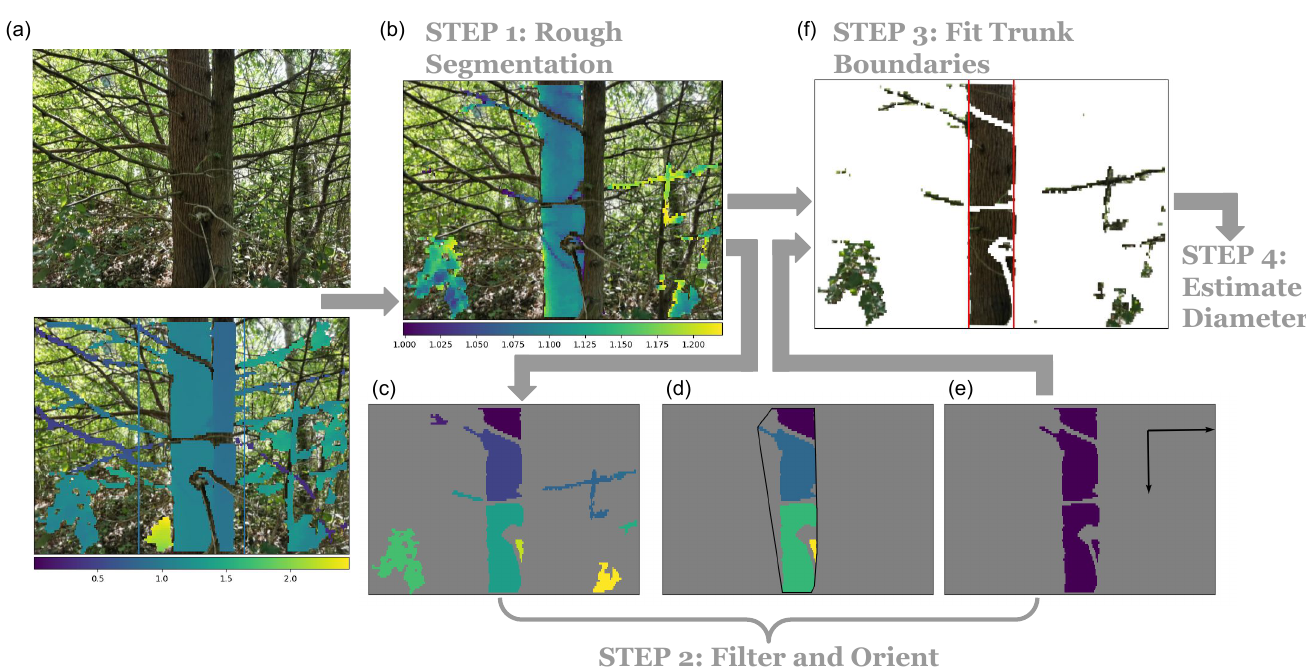
Figure 2. A four-step algorithm filters, orients, and segments captured images before estimating trunk diameter. The steps are demonstrated in the sample image ( a ), with the RGB image on the left and the raw depths overlaid on the right. The roughly segmented depth image ( I s ) is shown in ( b ), and the sub-steps of filtering and orienting the image to obtain a highly filtered image I f and the trunk’s principal axis are displayed in ( c – e ). The fitted trunk boundaries are shown in ( f